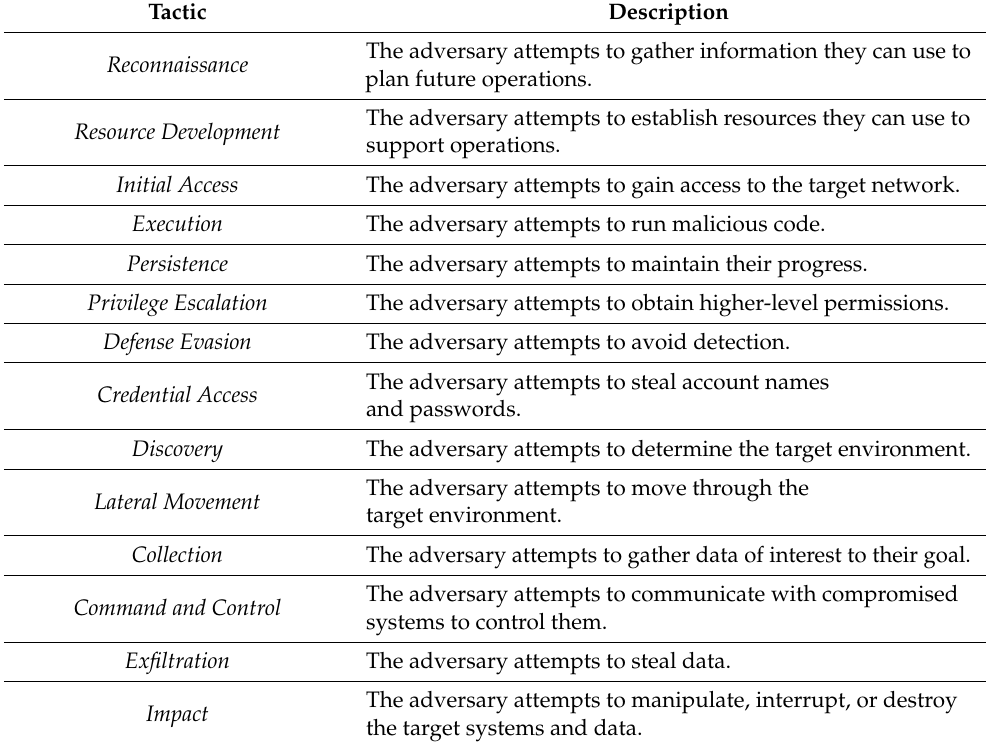
Table 1. MITRE ATT&CK